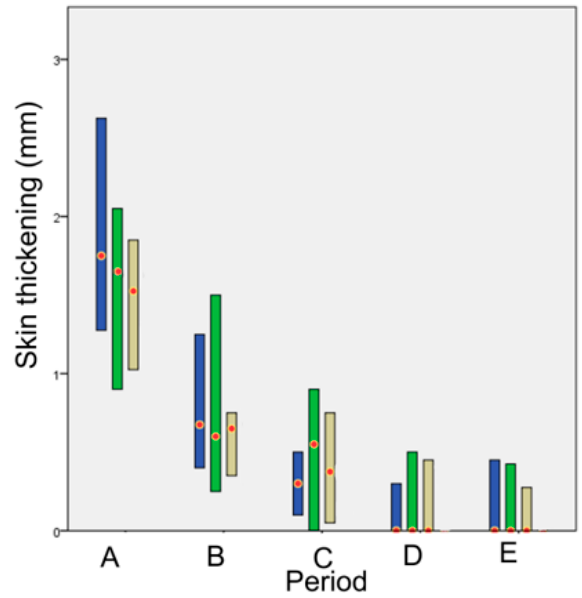
Figure 3. Median (red dot) and interquartile range (column) of skin thickening (in mm) for each technique (blue: staples, green: glue, gray: intradermal) in each time period. [period A: 1–8 po.d.; period B: 9–21 po.d.; period C: 22–63 po.d.; period D: 64–180 po.d.; period E: 181–365 po.d.]. In period A, the skin thickening as regards staples was significantly different from intradermal ( p < 0.001).